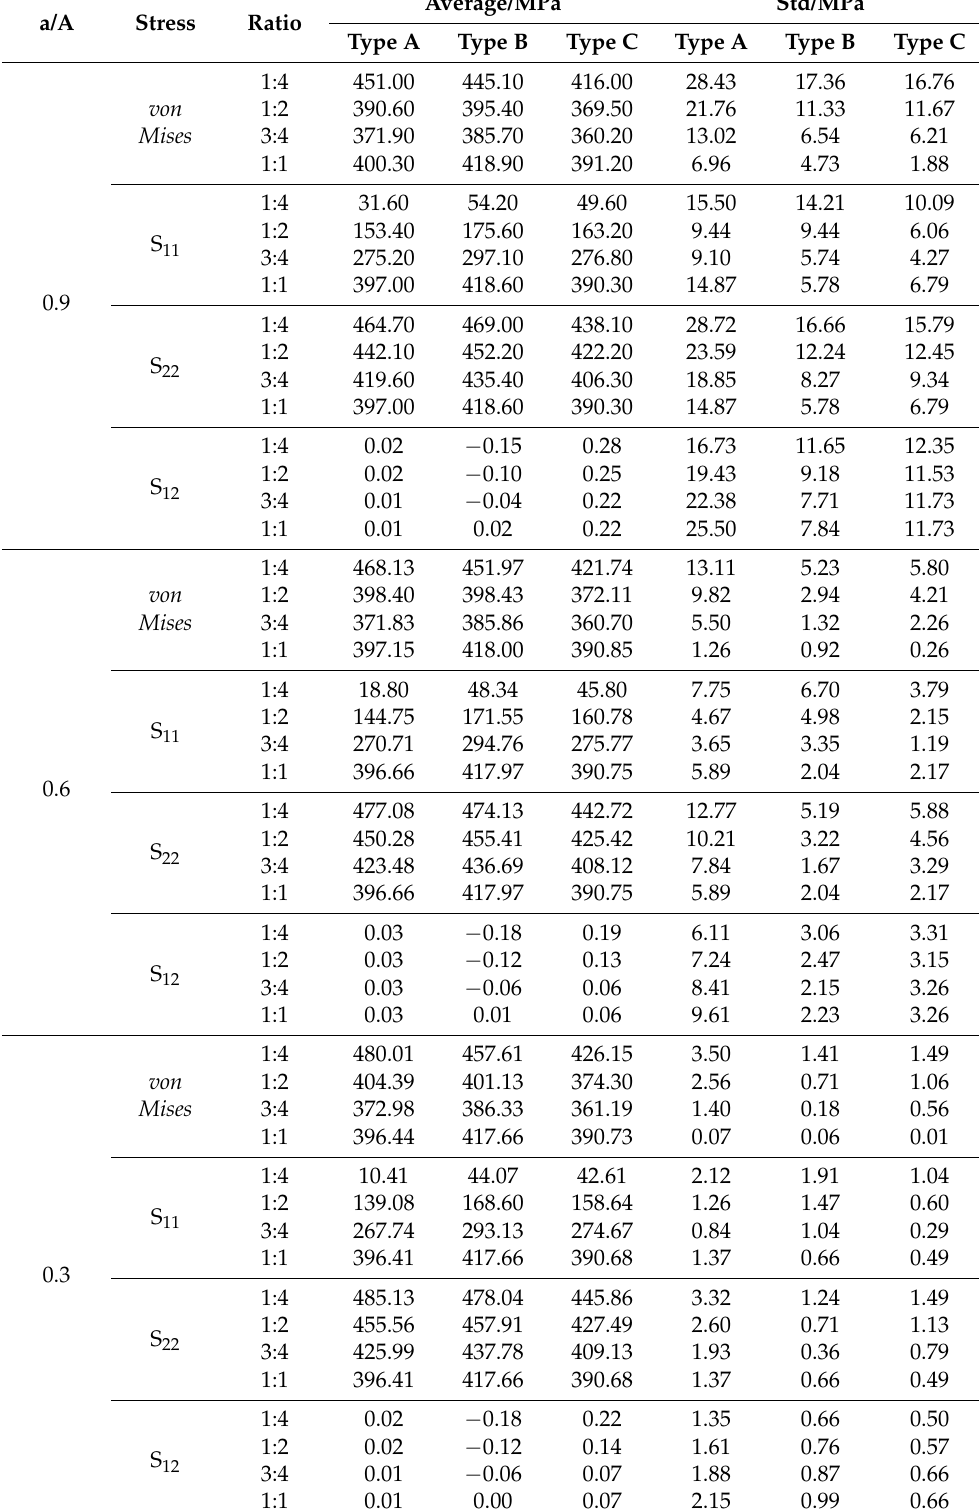
Table 3. Stress uniformity in the gage zone under different load